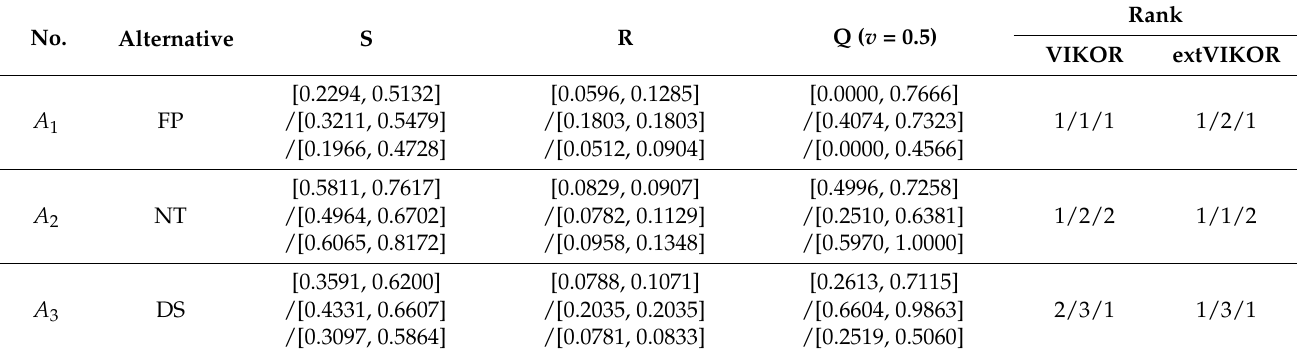
Table 16. The ranks according to the criteria of all groups. Preference #1/Preference #2/Preference